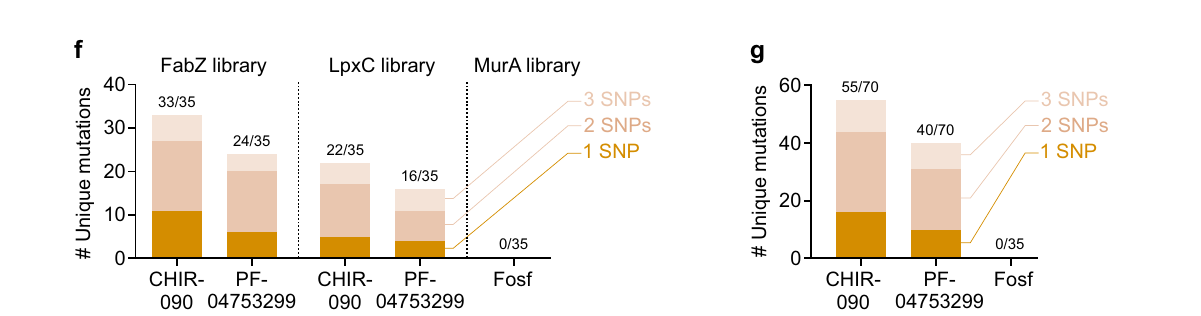
location of targeted residues in the LpxC protein is shown for both CHIR-090 and PF-04753299. Residues are colored according to the number of times they were targetedinisolatedresistantvariants.Thenumberofuniquemutationsin fabZ and lpxC that provide resistance to CHIR-090 or PF-04753299 and the number of mutationsin murA thatprovideresistancetofosfomycinareshown,eithergrouped per library and compound ( f ) orgrouped per compound only( g ).Foreach library- compound combination, 35 resistant variants were isolated and their fabZ , lpxC or murA gene was sequenced. The mutations found are subdivided into categories based on the minimal number of SNPs necessary to provide the observed amino acid change. Source data are provided as a Source Data fi le. Fosf fosfomycin, ACP acyl carrier